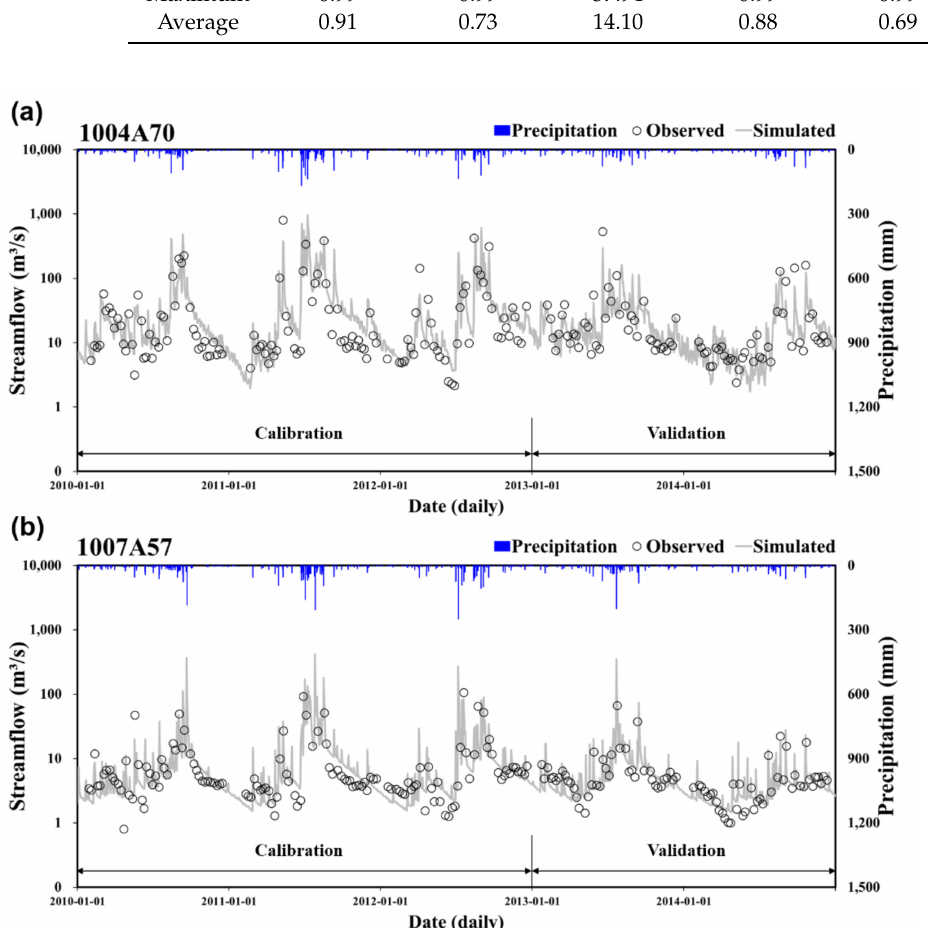
Figure 2. Comparison of observed and simulated streamflow of station code ( a ) 1004A70 and ( b ) 1007A57 for the calibration and validation